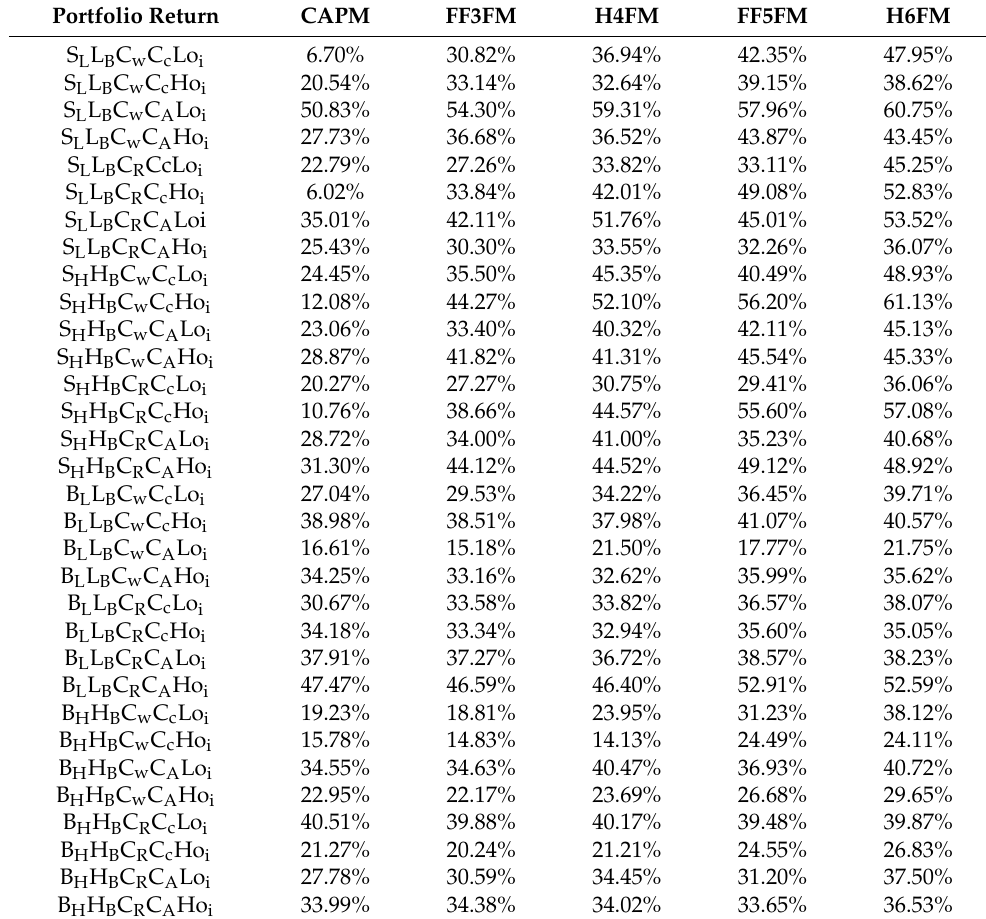
Table 4. Model comparison on the basis of Adj-R 2 .